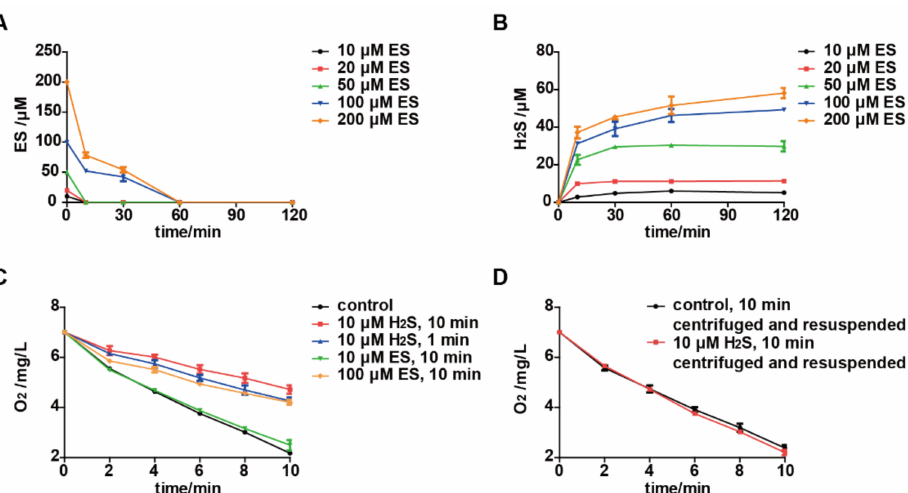
Figure 2. H 2 S inhibits the electron transport chain of S. cerevisiae . After adding elemental sulfur to the resting cells of S. cerevisiae , the residual concentrations of elemental sulfur ( A ) and H 2 S ( B ) were analyzed at different time intervals. ( C ) Oxygen consumption was measured after incubating 10 and 100 µ M elemental sulfur for 10 min or 10 µ M H 2 S with the resting cells of S. cerevisiae for 1 or 10 min, respectively. ( D ) The resting cells of S. cerevisiae were mixed with 10 µ M H 2 S first for 10 min. Then, the oxygen consumption was measured after H 2 S was removed. The resting cells of S. cerevisiae used were OD 600nm = 2.0. The 2% glucose was added as the substrate of the electron transport chain. Data are averages of three parallel experiments with standard deviations. ES, elemental